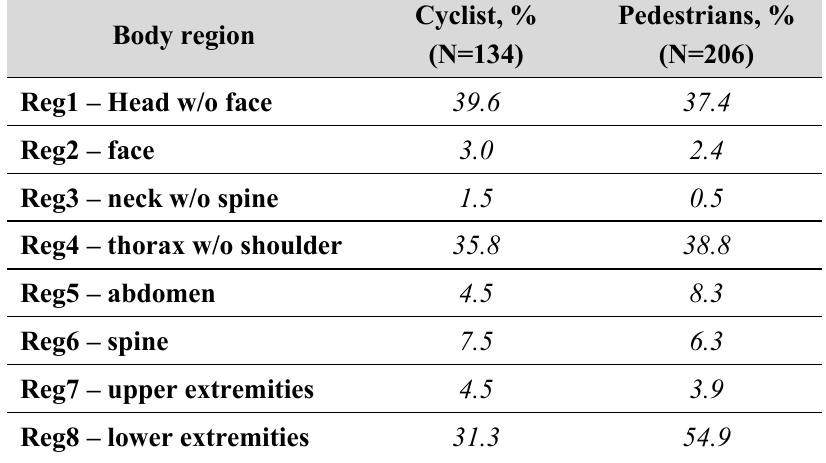
Table A7. Proportion of MAIS3+ injured cyclists and pedestrians sustaining MAIS3+ injuries from impact with the car in the listed body regions